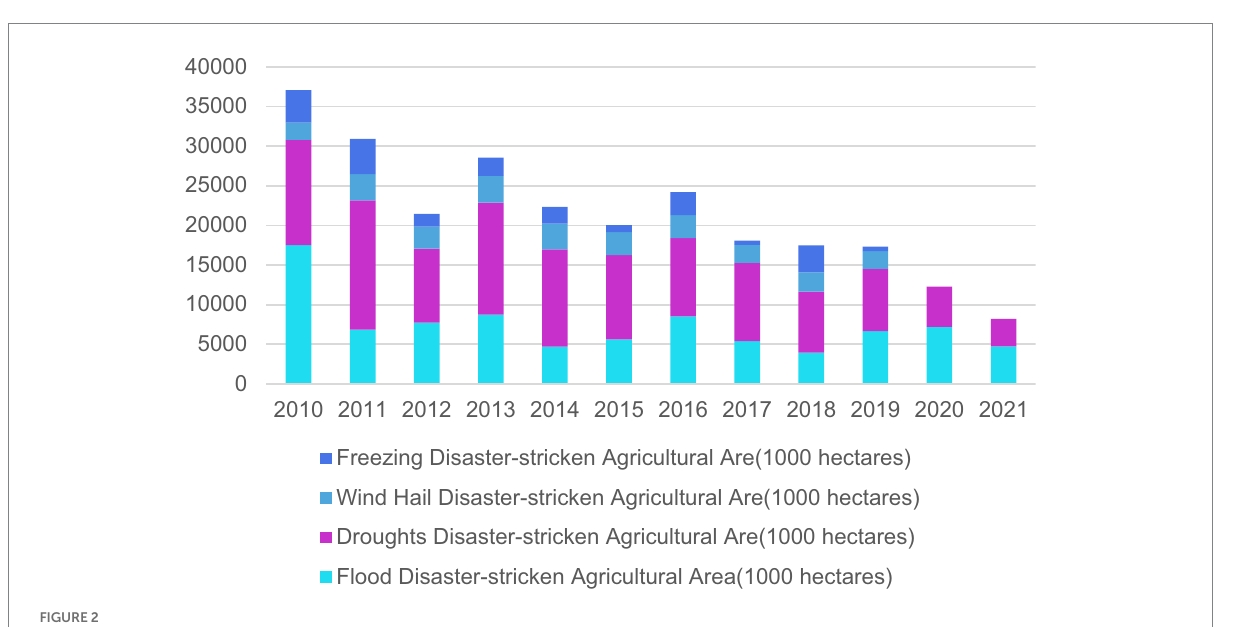
FIGURE 1 Change in rural disaster-stricken area in china between 2010 and 2021.